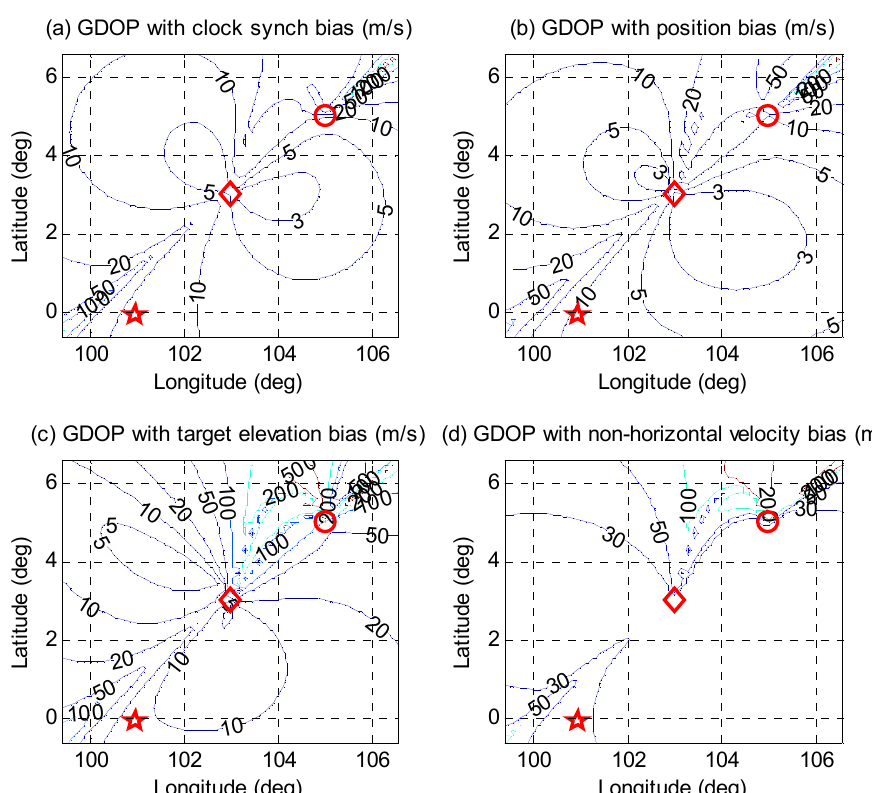
Figure 7. GDOPs of position estimation for the scenario of using LEO satellite, airplane and ground station.